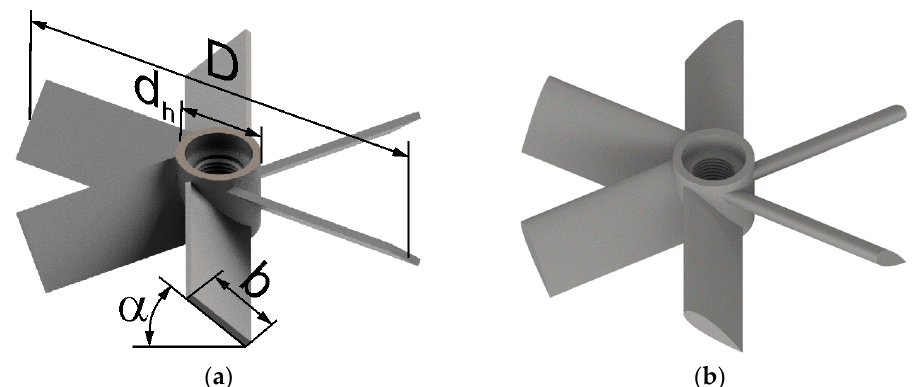
Figure 2. PBT impellers with flat profile ( a ) and airfoil profile ( b ).